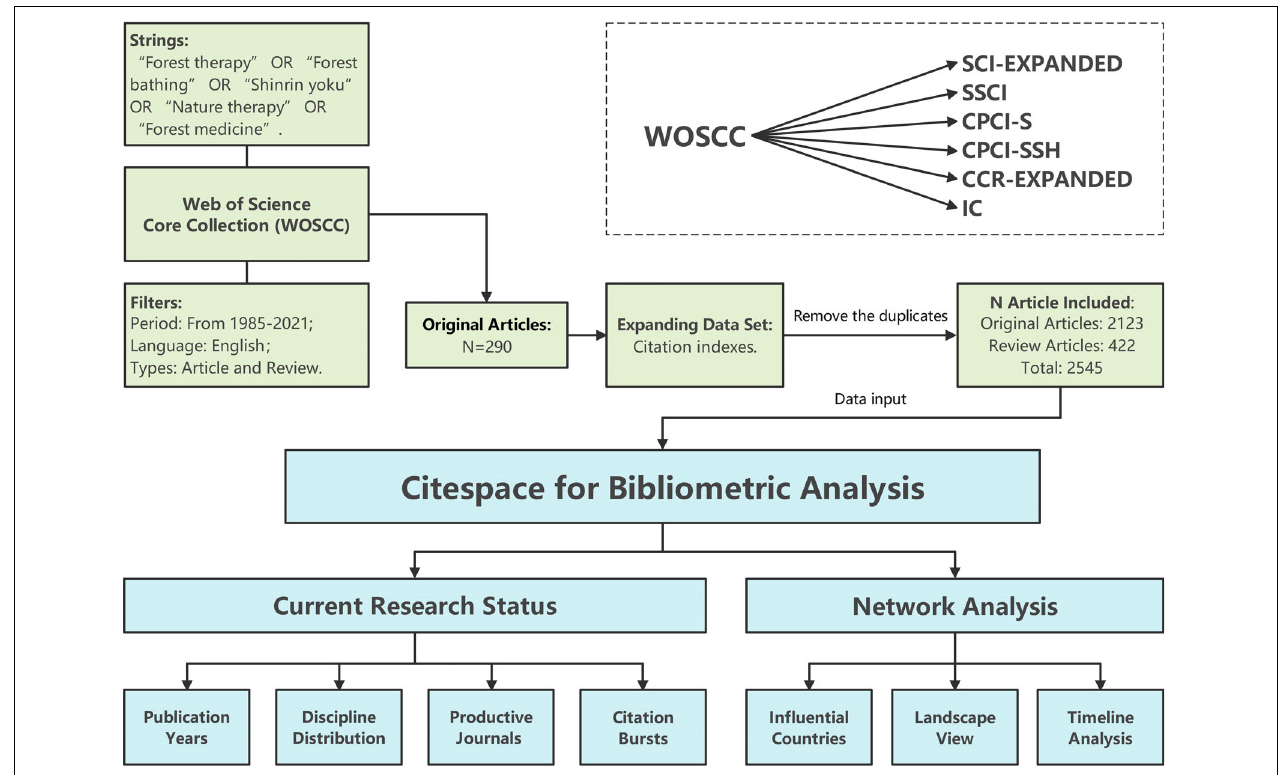
FIGURE 1 | Methodology steps used in the bibliometric analysis developed for forest therapy.